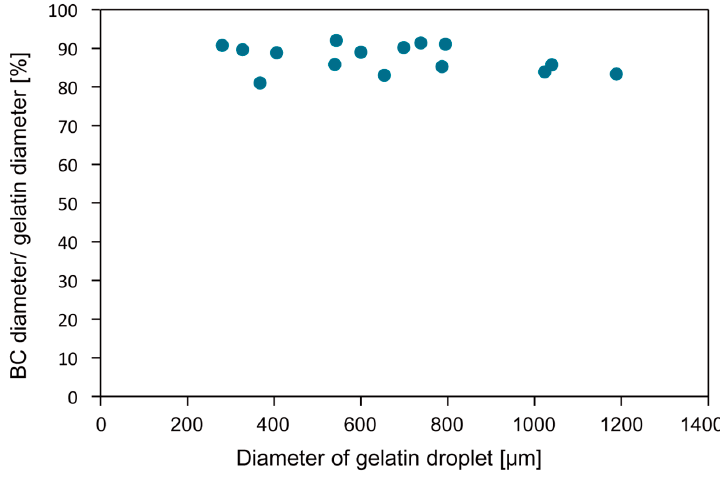
Figure 8. Fraction of BC microsphere diameter to gelatin microsphere diameter as a function of corresponding gelatin microsphere diameter using the microfluidic device.